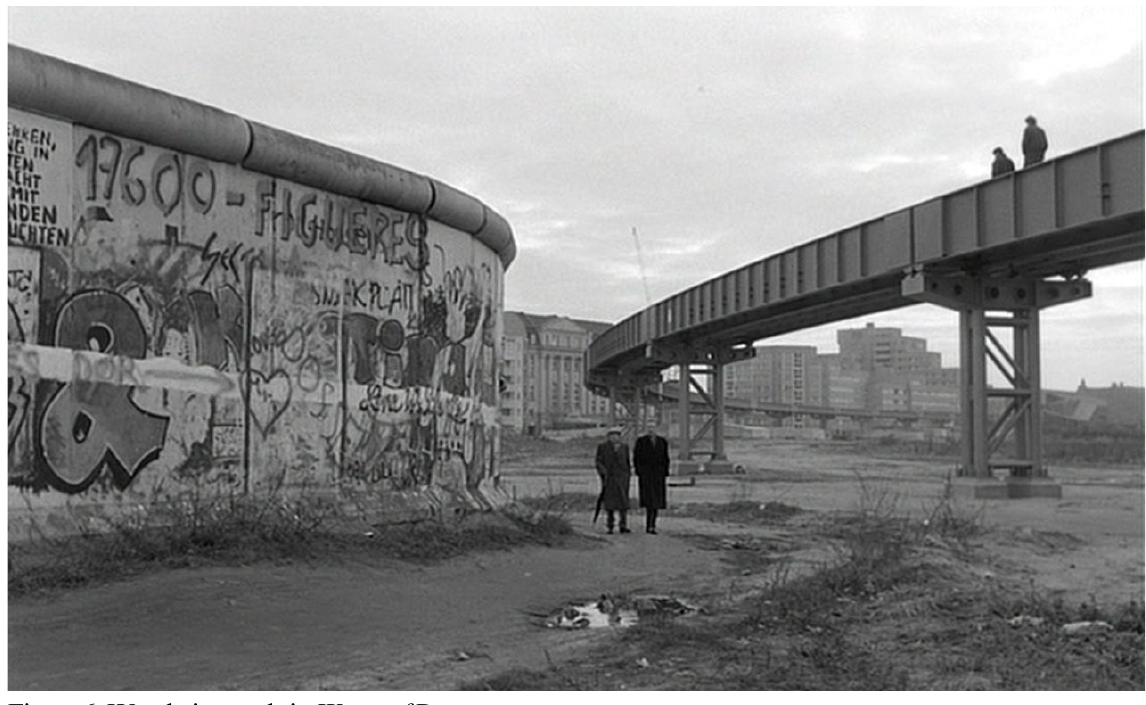
Figure 6: Wandering souls in Wings of